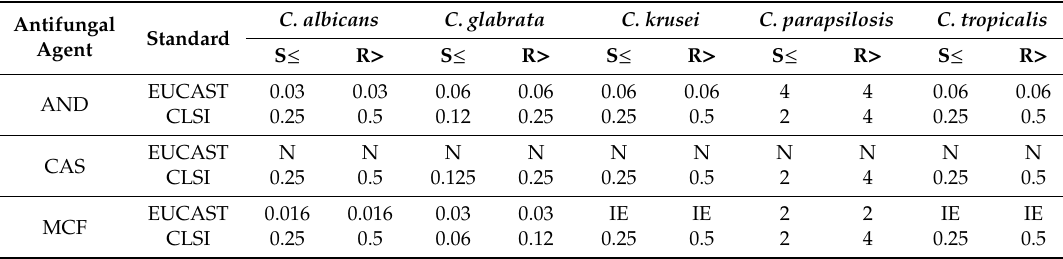
Table 1. Breakpoints of echinocandins established by EUCAST and